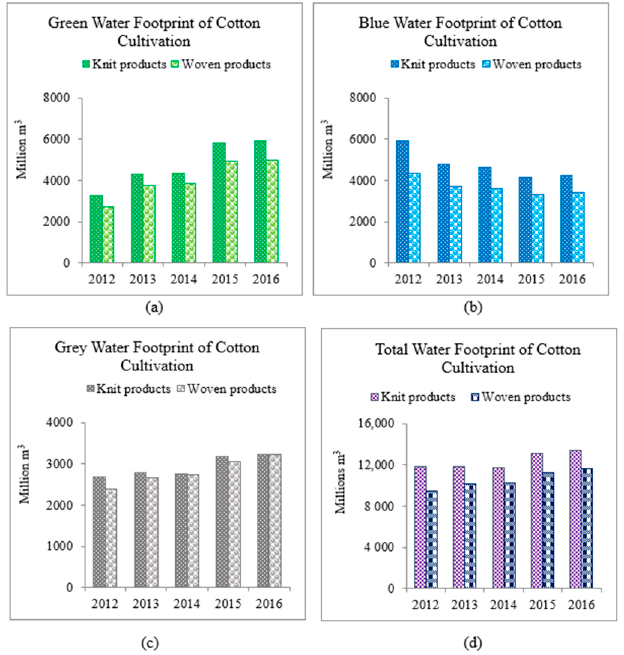
Figure 3. Water footprint of cotton cultivation for knit and woven products: ( a ) green water footprint, ( b ) blue water footprint, ( c ) grey water footprint and ( d ) total water footprint.